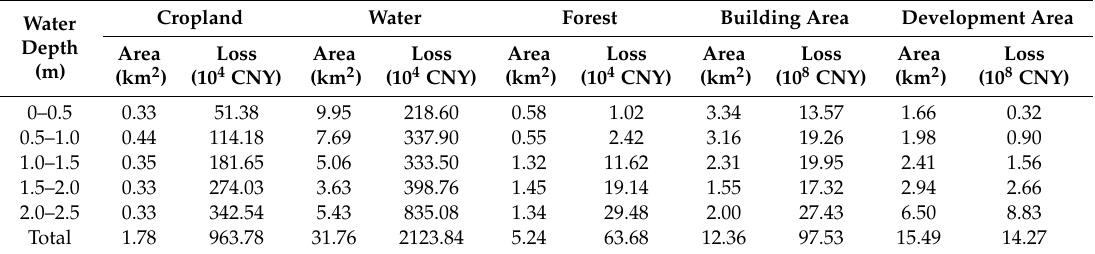
Table 5. Inundation extent and loss value of di ff erent land use types corresponding to di ff erent water